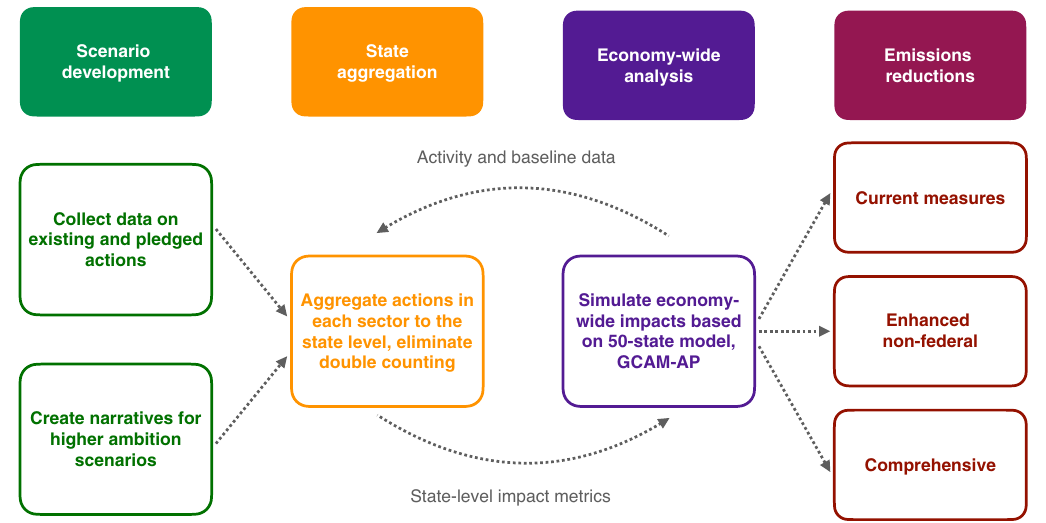
Fig. 5 Overview of the modeling process. The economy-wide emissions estimates based on sub-national action are the result of a coupled approach using a state aggregation methodology that is linked to